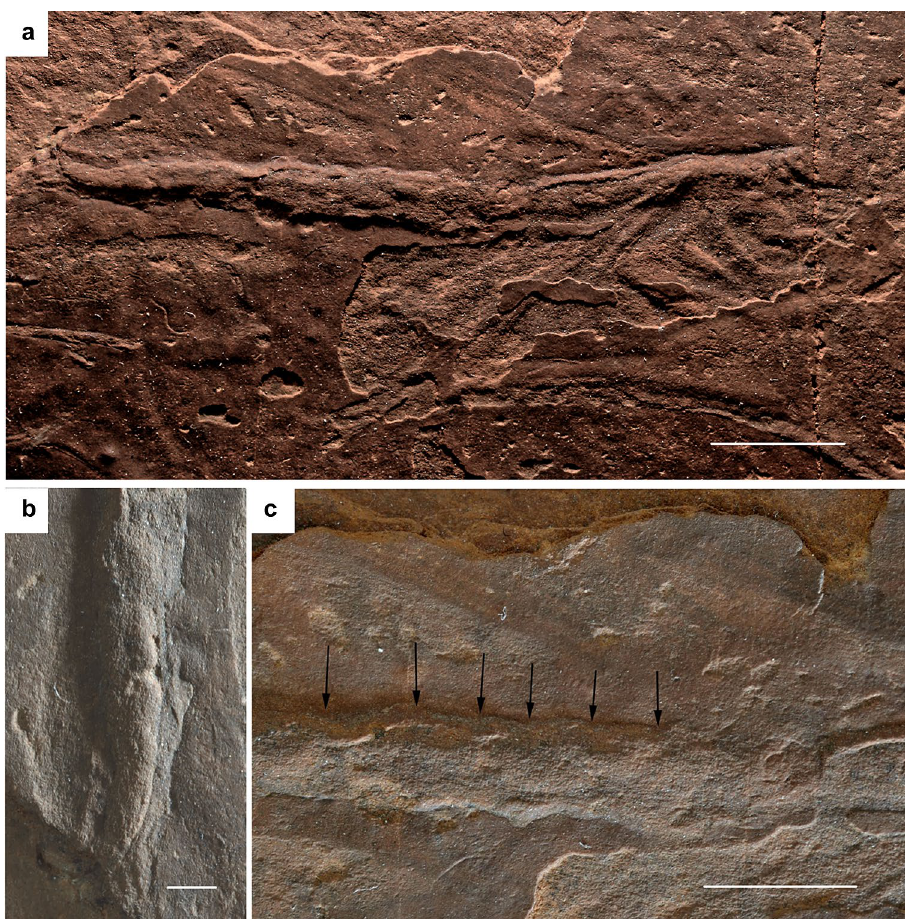
Figure 1. Phasmichnus radagasti nov. gen. et nov. sp., holotype MNHN.F.A71341. ( a ) Photograph of general habitus. ( b ) Close-up on apex of abdomen. ( c ) Close-up on abdomen base (arrows: putative lateral limits of segments). Photographs under natural light by V.N.-M. Scale bars, 10 mm ( a ), 5 mm ( b ), 1 mm ( c